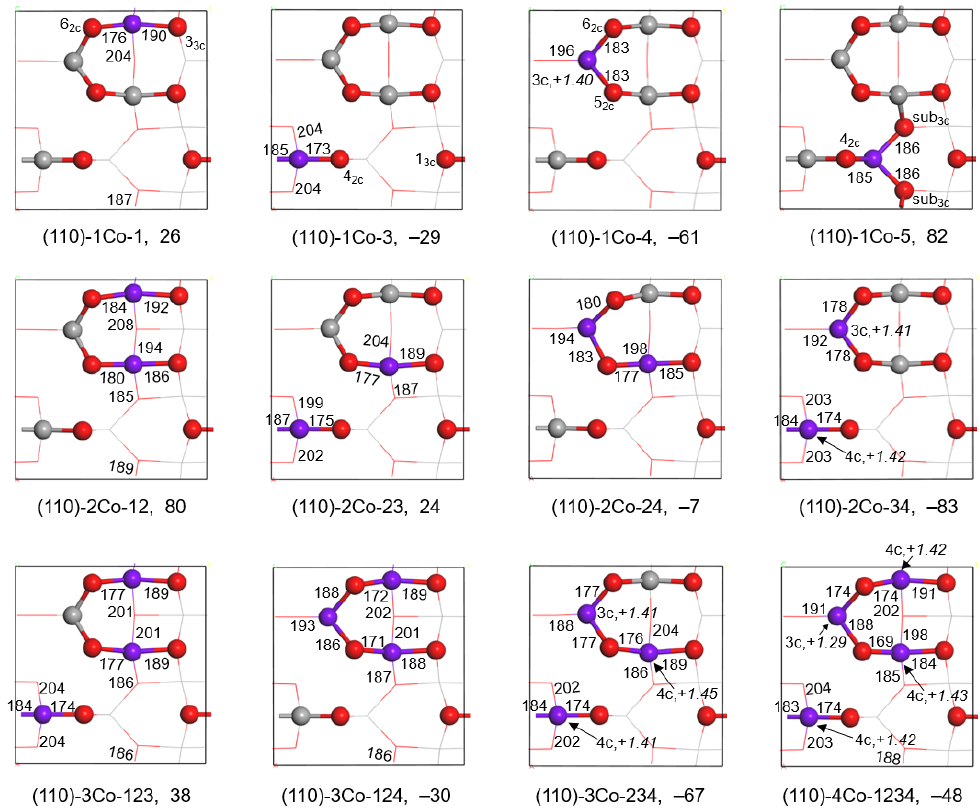
Figure 1. Co 3+ cations substituted for 1~4 Al 3+ cations of γ -Al 2 O 3 (110) surface. The red, gray and violet balls represent the surface O, Al and Co atoms, respectively. The coordination numbers and Bader charges of Co atoms are next to the violet balls. The substitution energies (kJ/mol), Bader charges ( e ) and bond distances (pm) have been shown in the figure. For two Co 3+ cations substitution for Al 3+ cations of γ -Al 2 O 3 (110) surface. The substi- tution energies of (110)-2Co-12, (110)-2Co-23, (110)-2Co-24 and (110)-2Co-34 are 80, 24, − 7 and − 83 kJ/mol, respectively. It indicates that the substitution reaction is